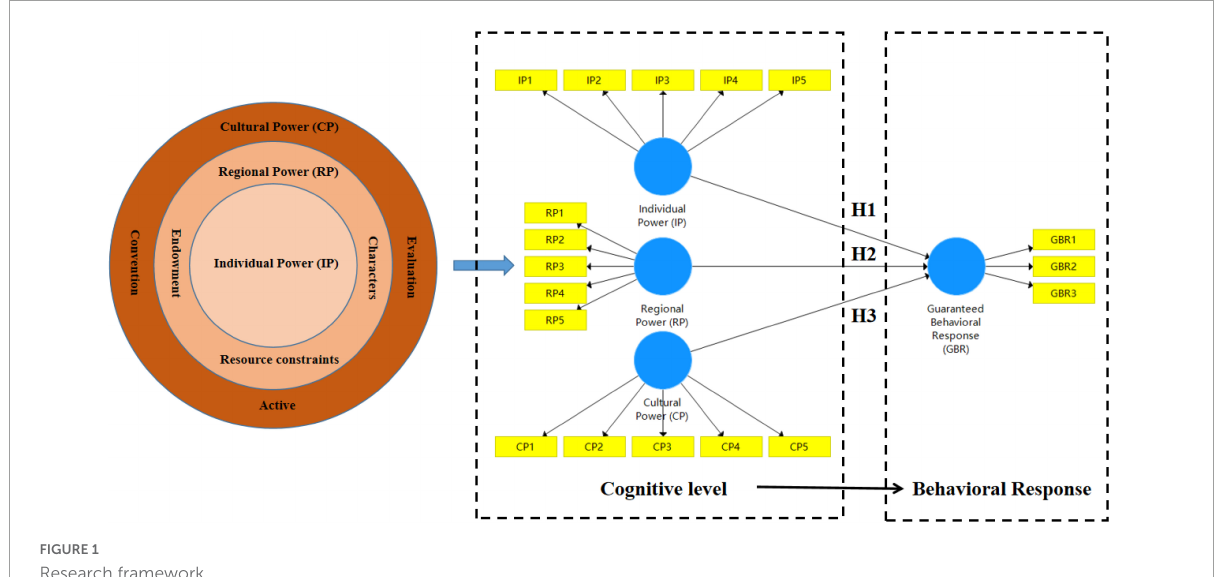
FIGURE1 Research framework.